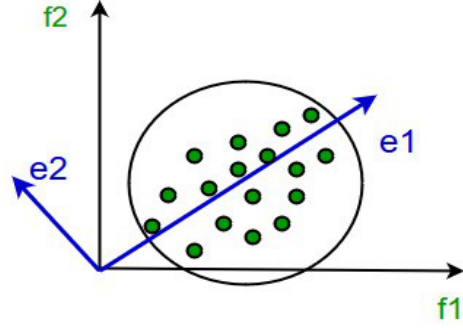
Figure 3. Schematic representation of dataset eigenvectors.